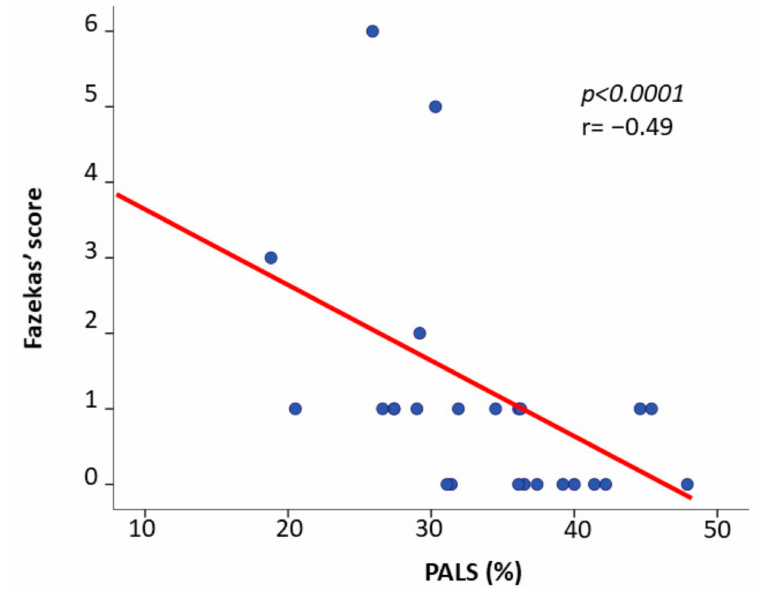
Figure 4. Scatterplot and regression line of the inverse relation between peak atrial longitudinal strainand Fazekas Score in Anderson-Fabry Disease